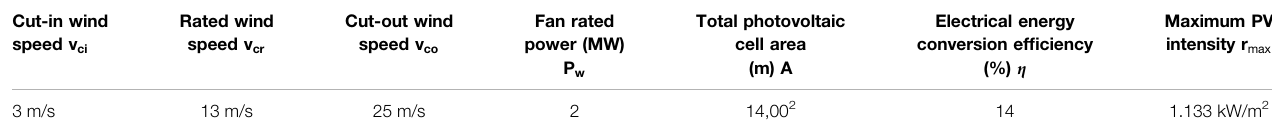
TABLE 5 | Simulation parameters of wind power and photovoltaic power.